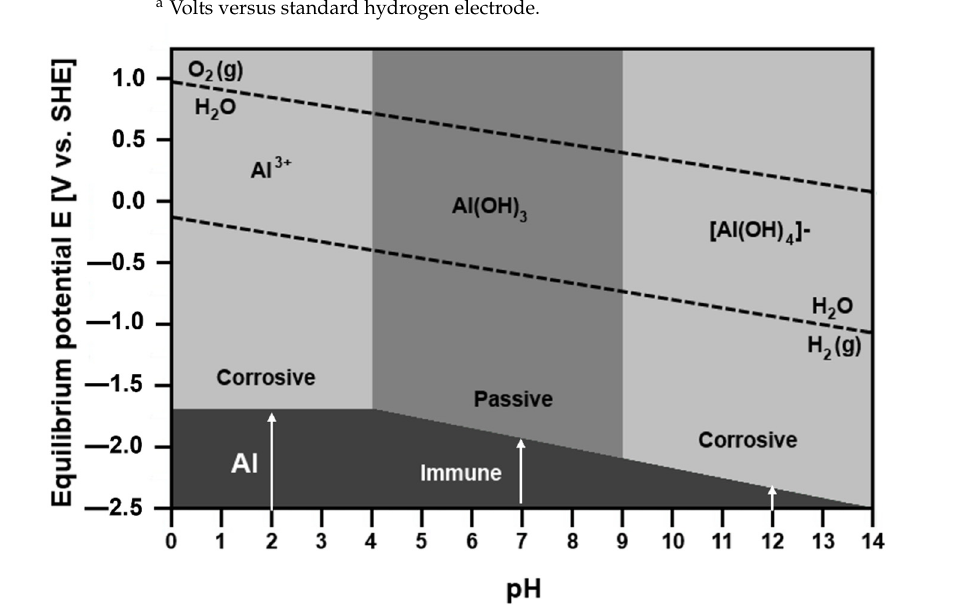
Figure 7. Equilibrium E–pH diagram of Al, replotted from [70].